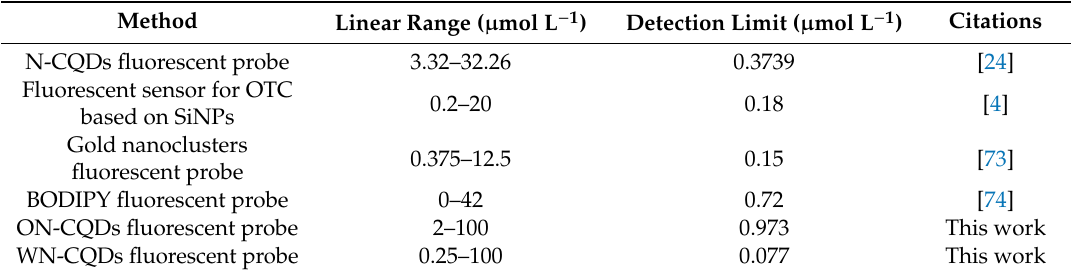
Table 1. Comparison with previous methods of OTC analysis.